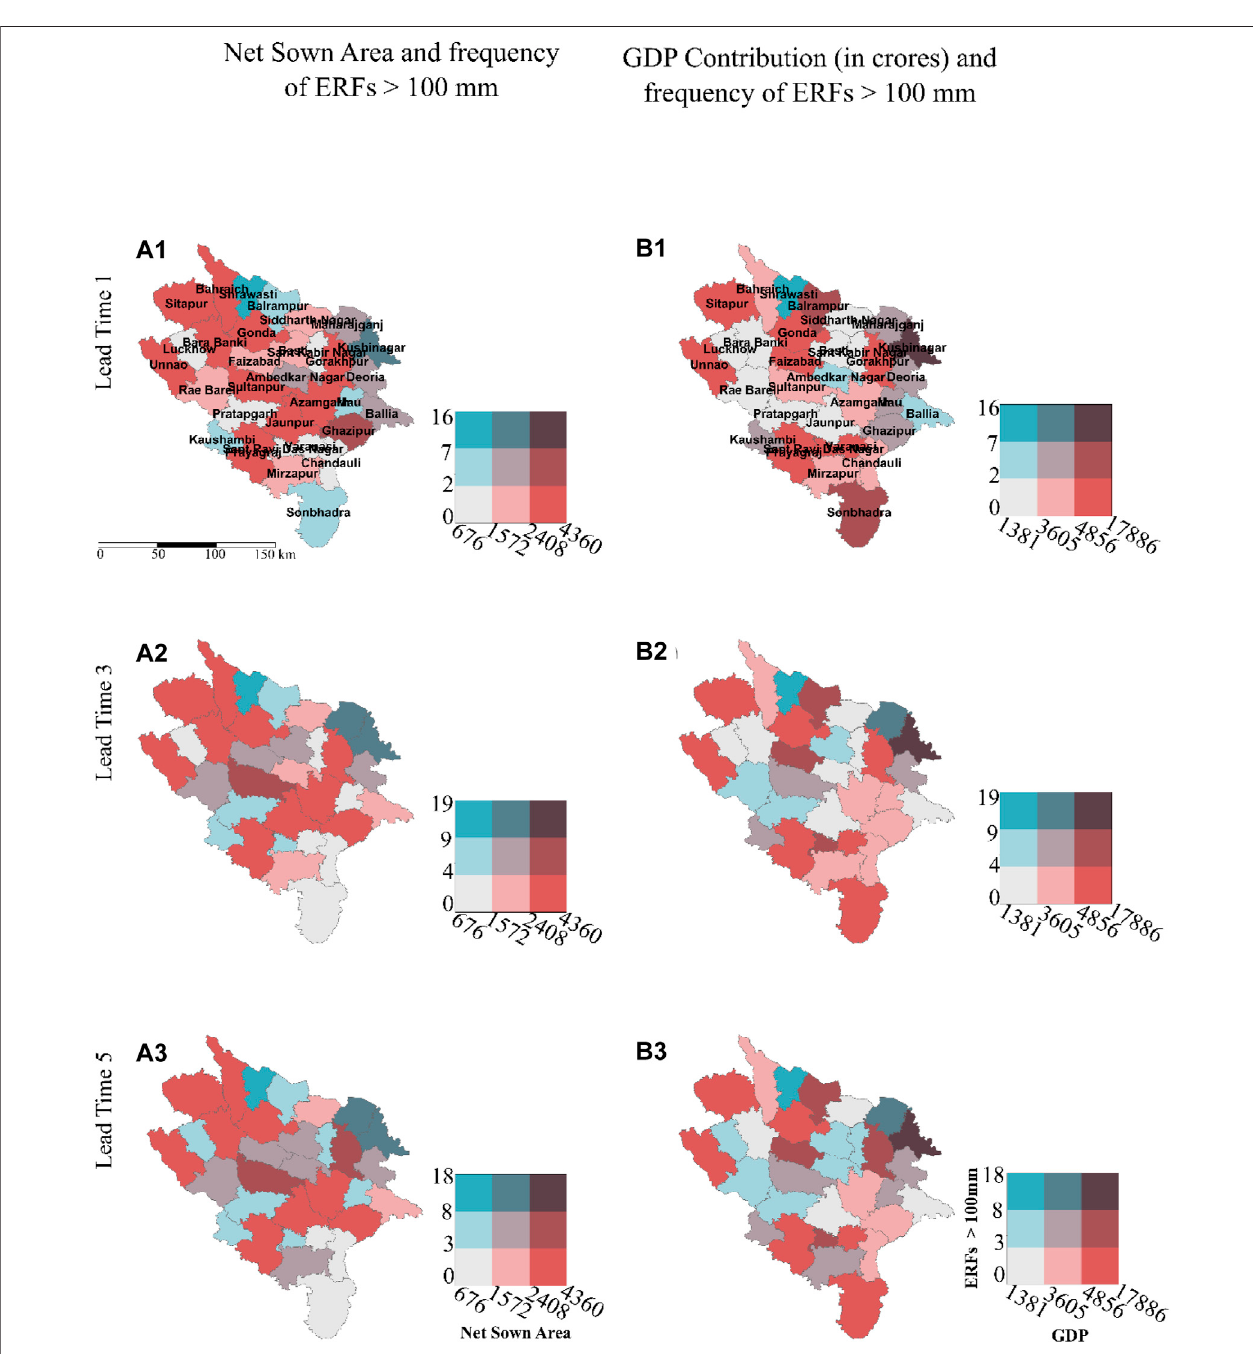
FIGURE 5 | A bivariate choropleth map showing the combined effect of the number of ERFs with net sown area (Panels (A1 – A3) ) and total GDP contribution (Panels (B1 – B3) ) across the districts at three lead times and 100 mm threshold.